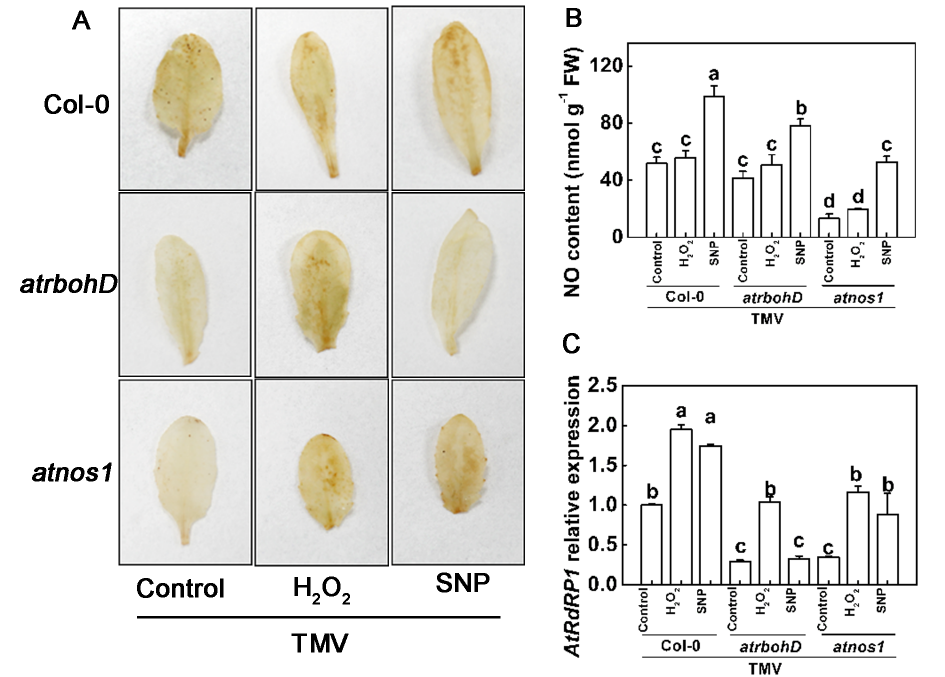
Figure 5. Relationship of H 2 O 2 , NO, and AtRDR1 transcripts in wild-type and mutant Arabidopsis plants. Effects of TMV inoculation and exogenous application of hydrogen peroxide (H 2 O 2 ) and nitric oxide (NO) on endogenous H 2 O 2 and NO concentrations and on transcript levels of RNA-dependent RNA Polymerase 1 in non-inoculated upper leaves of wild-type and mutant Arabidopsis plants ( AtRDR1 ). The non-inoculated upper leaves were pretreated with H 2 O 2 or SNP 12 hours before TMV inoculation, and leaf samples were collected at 2 days post inoculation. A . H 2 O 2 detection using DAB histochemical staining. B . NO concentration. C . AtRDR1 transcripts. The results are expressed as the mean 6 SD, n = 4. The letters indicate significant differences between the treatments ( P ,